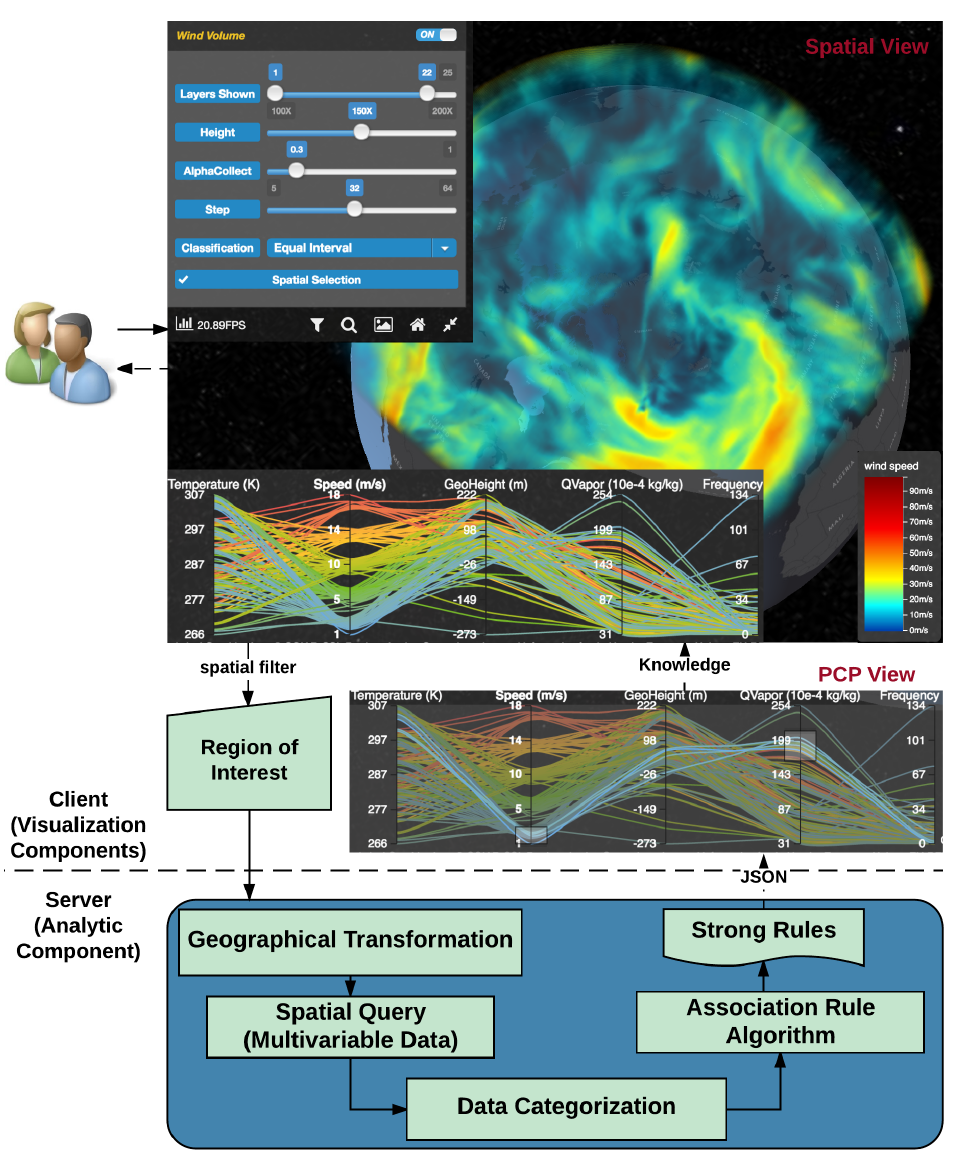
Figure 1. Workflow of association rule-based multivariate analysis and visualization. Multiple climate data processing services are provided on the server side. The multiview technique is employed to visualize data on the client